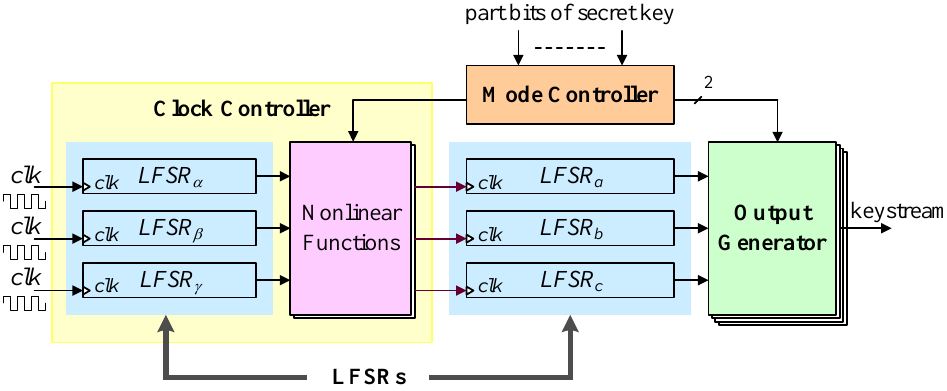
Figure 4. The block diagram of keystream generator.